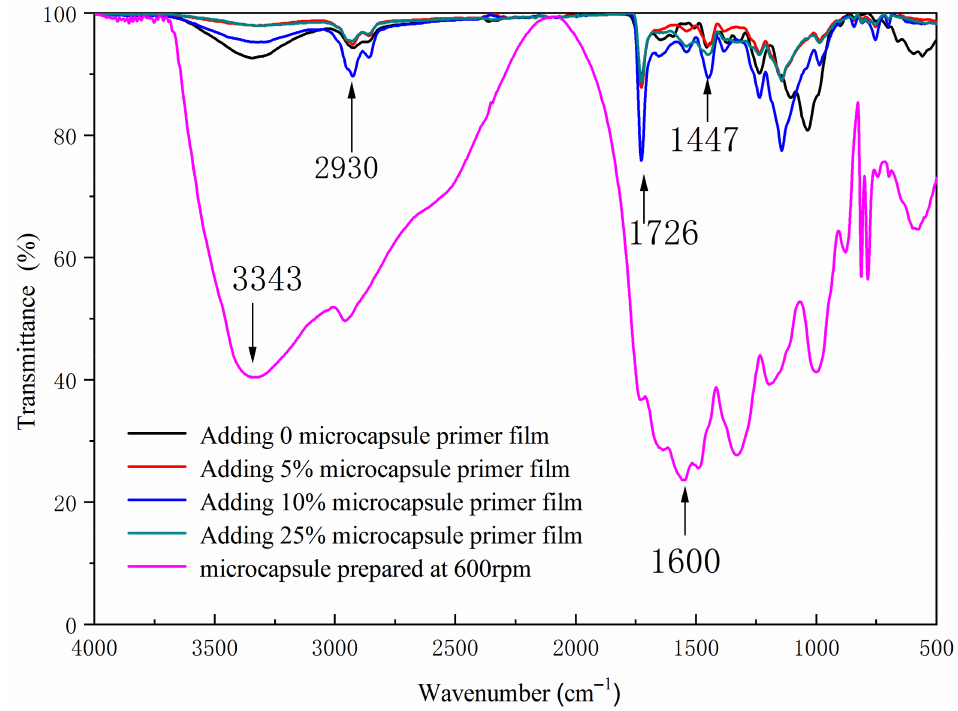
Figure 9. The FTIR of primer film with different microcapsule concentration.